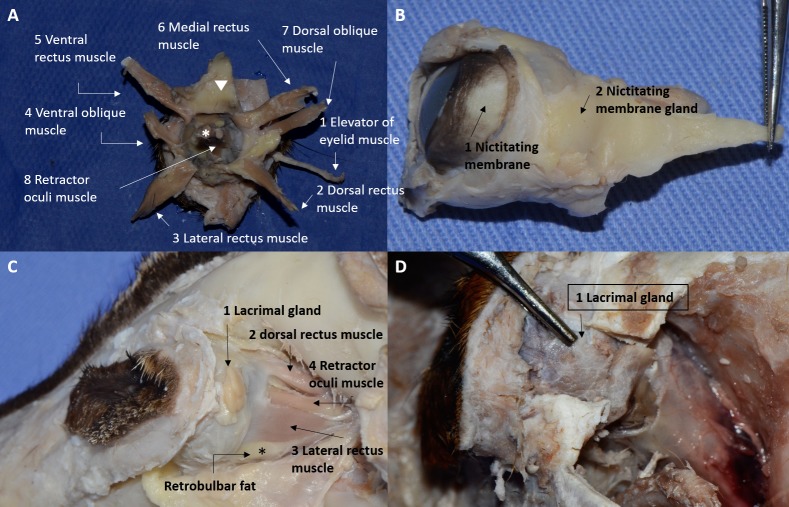
Gross anatomical image of the adnexa of crab-eating fox.(A) Posterior view of the extraocular muscles of crab-eating fox: 1, elevator of eyelid muscle; 2, dorsal rectus muscle; 3, lateral rectus muscle; 4, ventral oblique muscle; 5, ventral rectus muscle; 6, medial rectus muscle; 7, dorsal oblique muscle; 8, retractor oculi muscle. *Note the optic nerve and the inner face of the nictitating gland (arrowhead), covered by adipose and connective tissue. (B) Lateral view of the nictitating membrane of crab-eating fox: 1, palpebral face of the nictitating membrane showing pigmentation; 2, nictitating membrane gland covered by connective tissue. (C and D) Lateral view of the lacrimal gland showing macroscopic differences between crab-eating fox (C) and the domestic dog (D): 1, note the multilobulated oval shape in crab-eating fox and the irregular shape in the domestic dog; in the lateral aspect, it is possible to observe 2, the dorsal rectus muscle and 3, lateral rectus muscle, as well as 4, the retractor oculi muscle and *retrobulbar fat.